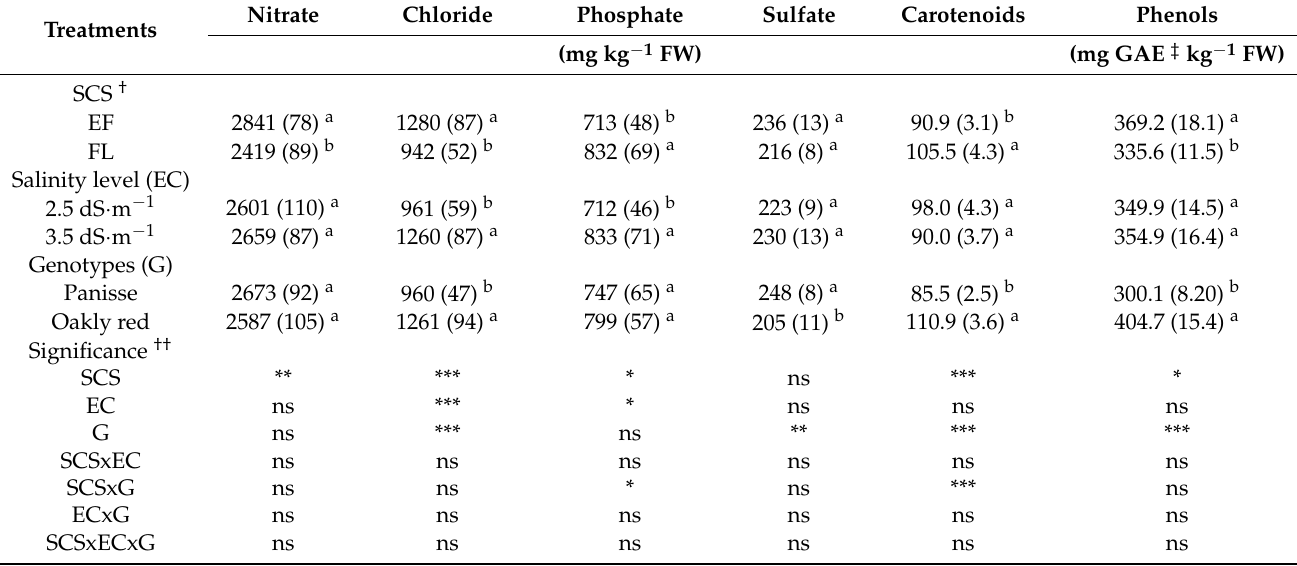
(Table 3), irrespective of the SCSs. Table 3. Effect of soilless cultivation system (SCS), salinity level (EC) of nutrient solution, and genotype (G) on inorganic anions and antioxidant compound concentrations of oak-leaf lettuce (autumn cycle). Treatments